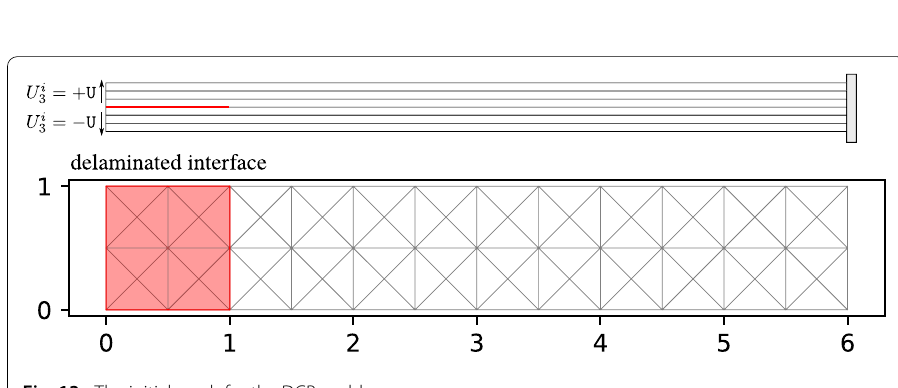
Fig. 13 The initial mesh for the DCB